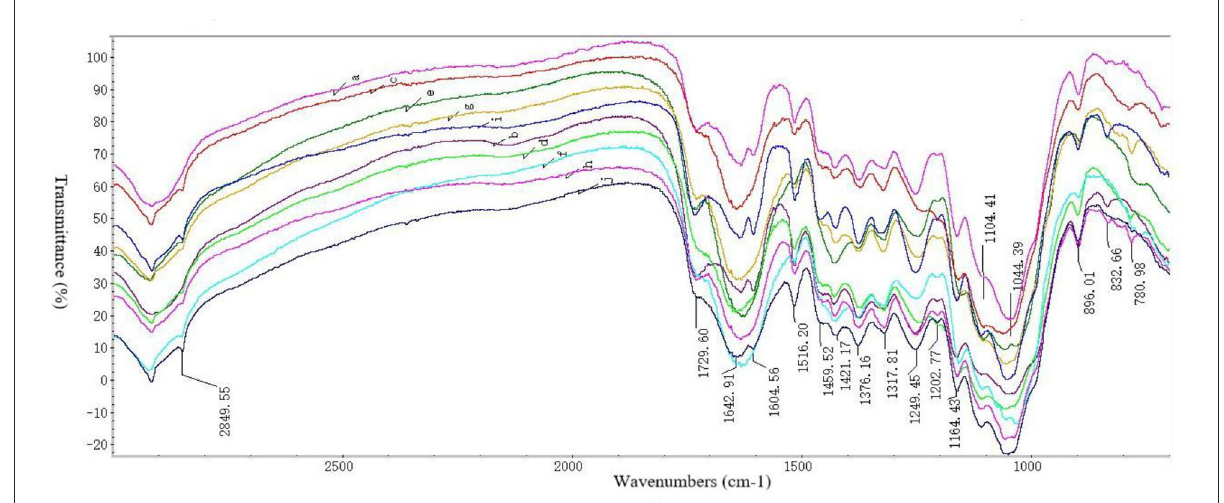
FIGURE2 FTIR spectra of feedstuffs before and after steam explosion processing (a: raw corn cob; b: steam-exploded corn cob; c: raw rice straw; d: steam-exploded rice straw; e: raw peanut shell; f: steamed-exploded peanut shell; g: raw millet stalk; h: steamed-exploded millet stalk; i: raw sugarcane tip; j: steam-exploded sugarcane